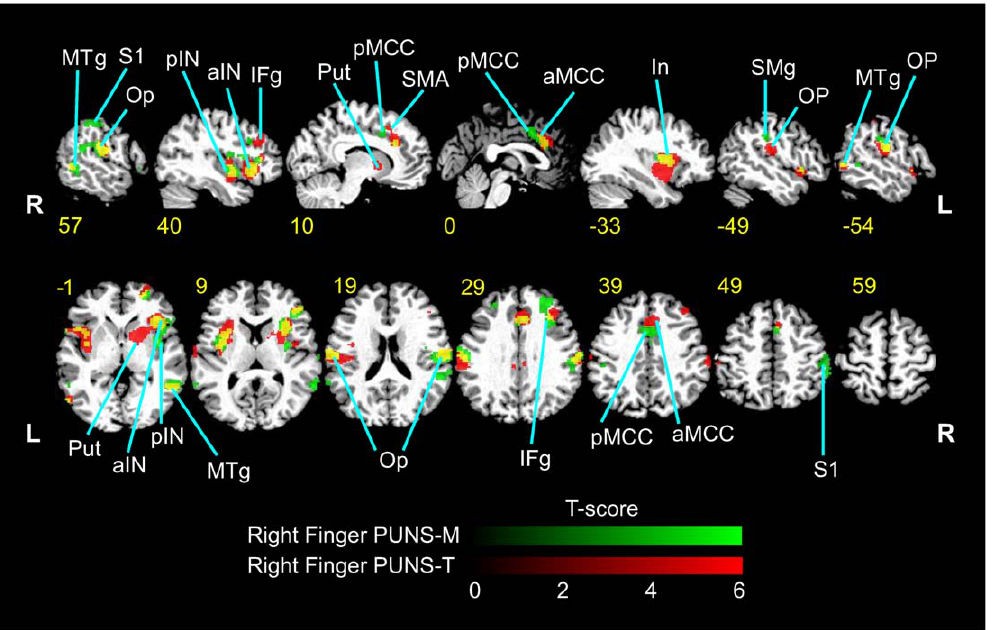
Figure 6. Differential stimulation of somatosensory brain circuits elicited by PUNS as indicated by BOLD contrast signals. Psuedocolor fMRI images illustrating BOLD contrast signals (p , 0.001; threshold 9 voxels) are shown for responses to PUNS-M ( green LUT) and PUNS-T ( red LUT) stimulation of the right index finger. Areas which were co-activated by both PUNS-M and PUNS-T are indicated by yellow voxels. Slice numbers shown in yellow text are based on MNI conventions. Anatomical areas activated are indicated by the following abbreviations: MTg = medial temporal gyrus; S1 = primary somatosensory cortex; Op = parietal operculum; pIN = posterior insula; aIN = anterior insula; IFg = inferior frontal gyrus; Put = putamen; pMCC = posterior middle cingulate cortex; SMA = supplementary motor area; aMCC = anterior middle cingulate cortex; SMg = supramarginal gyrus.